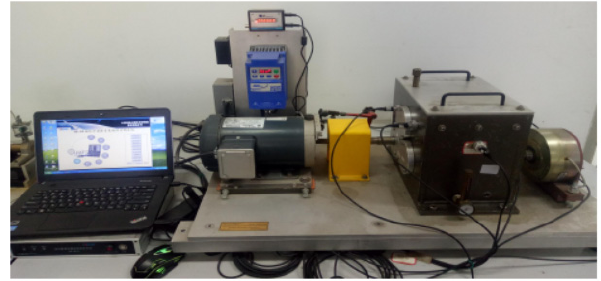
Figure 22. Gearbox experimental platform.